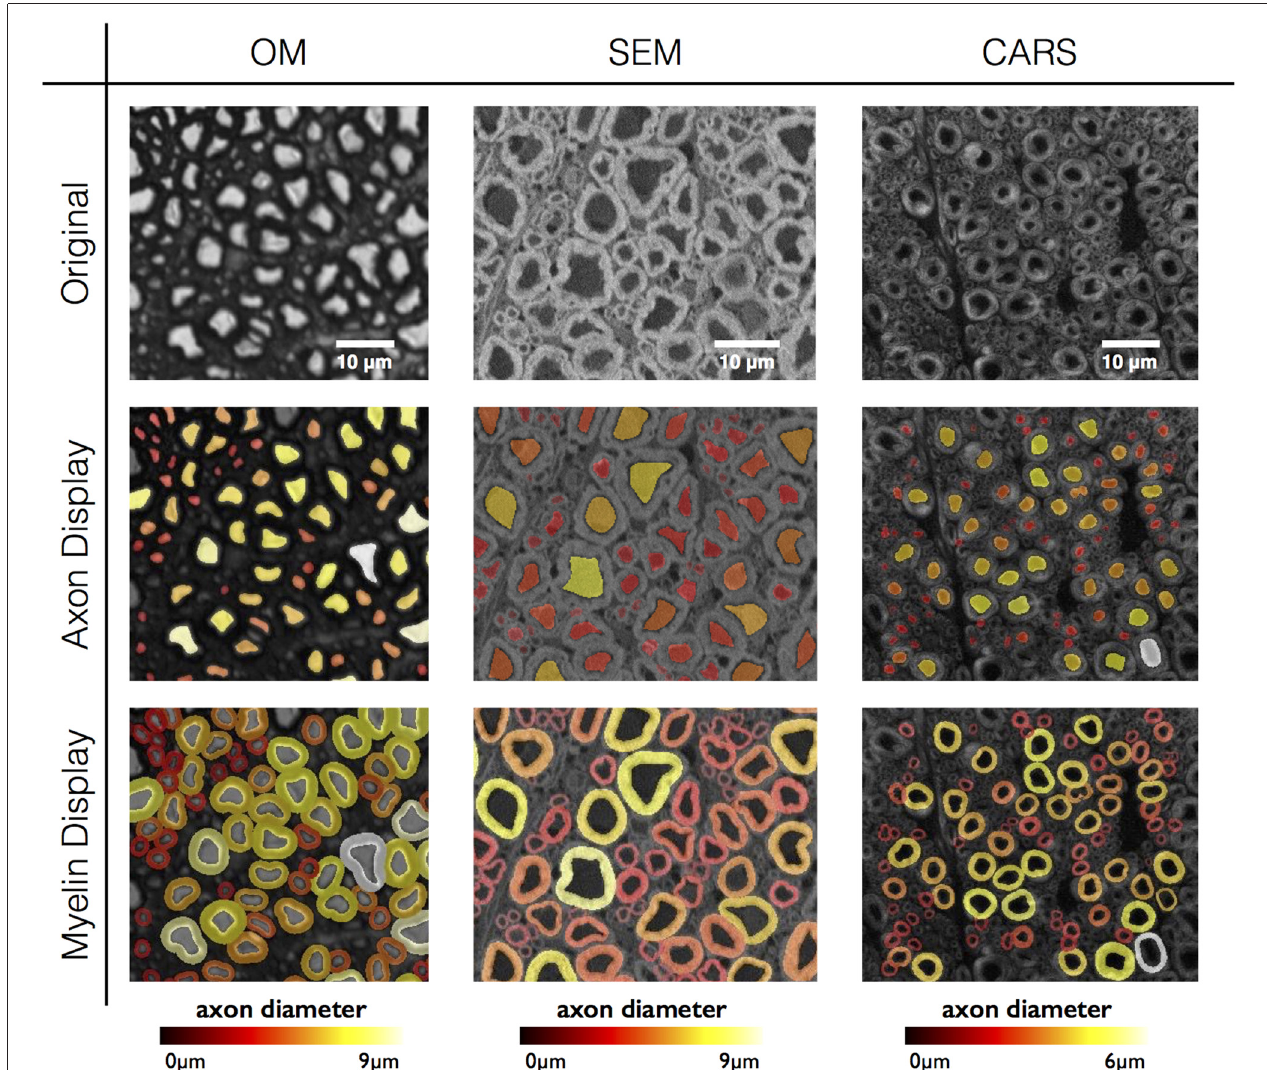
FIGURE 6 | Results in various imaging modalities: optical microscopy (OM) from a cat spinal cord, scanning electron microscopy (SEM) and coherent anti-Stokes Raman scattering (CARS) microscopy from a rat spinal cord. All figures are color-coded for axon diameter. Note: myelin sheaths overlap more on the OM contrast due to the low resolution, inducing a blurring of the myelin sheath and therefore an apparent over-segmentation. This effect could be compensated using deconvolution algorithms applied to the image, although this will require further